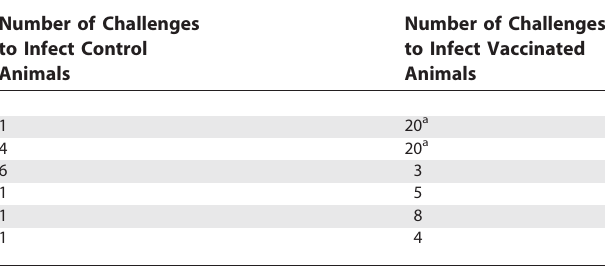
Table 3. Outcome of One Virtual Repeated